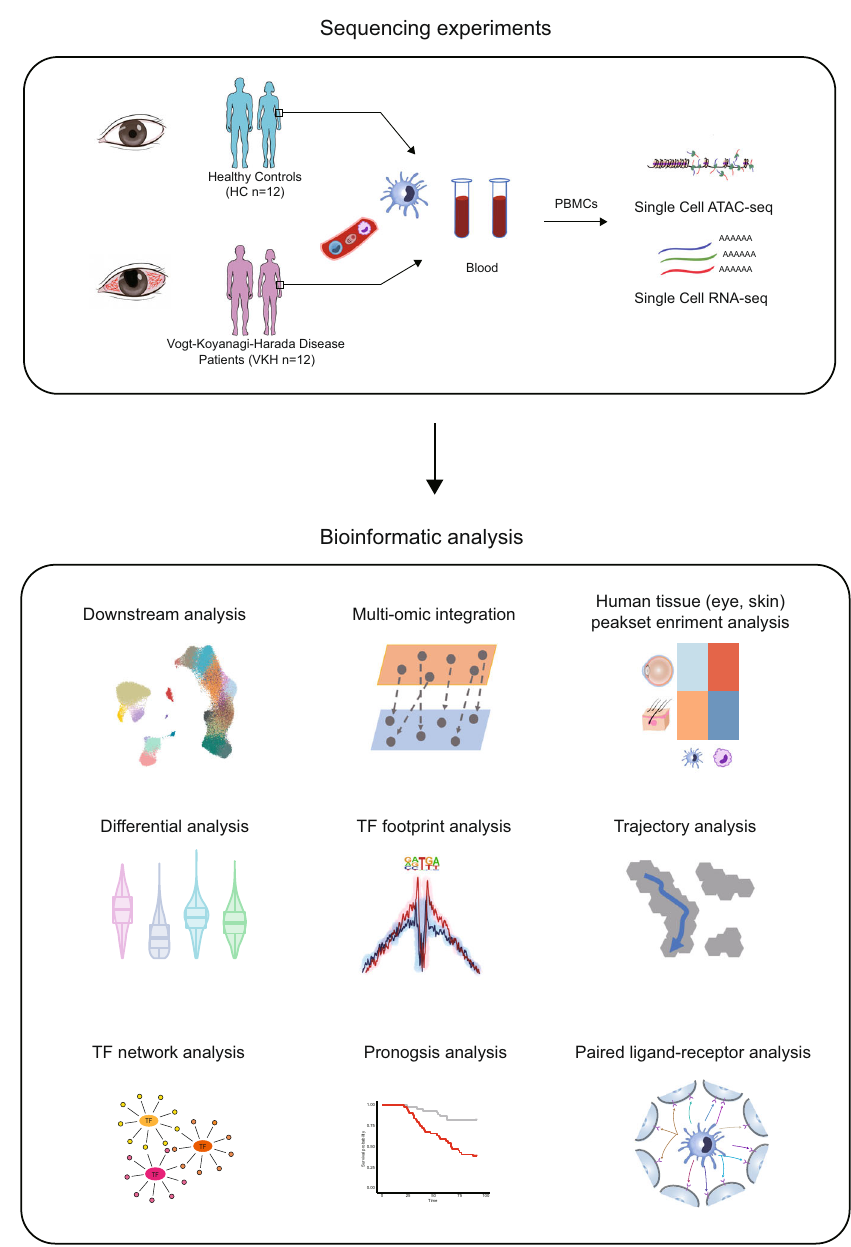
Fig. 1 The single-cell multiomic experimental design. a Schematic representation of the single-cell pro fi ling of PBMCs from healthy controls ( n = 12) and VKH disease patients ( n = 12) in this study, sequencing experiments and downstream bioinformatic analyses. All data are aligned and annotated to hg38 reference